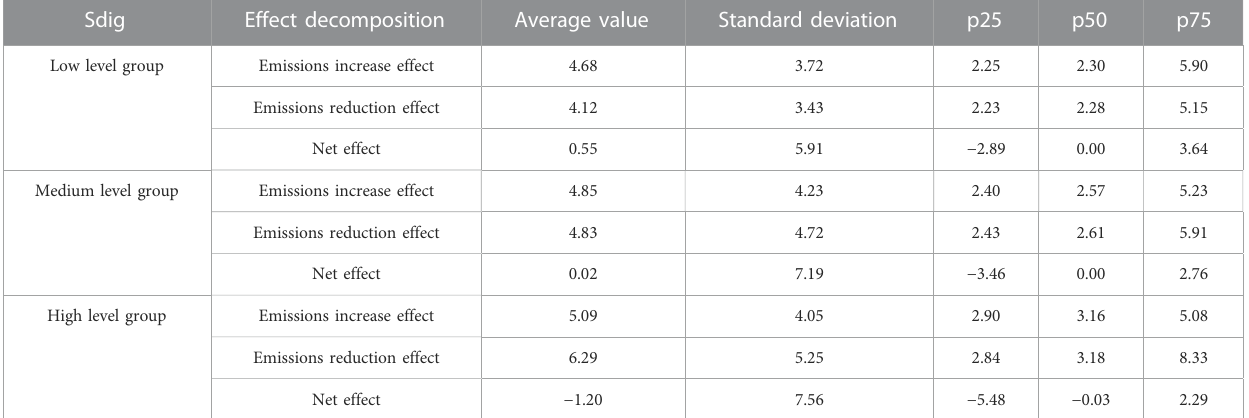
TABLE 6 Differences in the net effect (%) of air pollution at different levels of the digital economy.